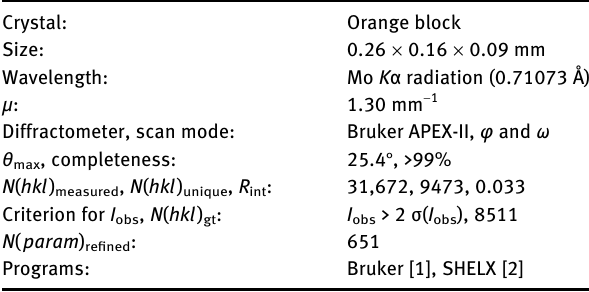
Table  : Data collection and